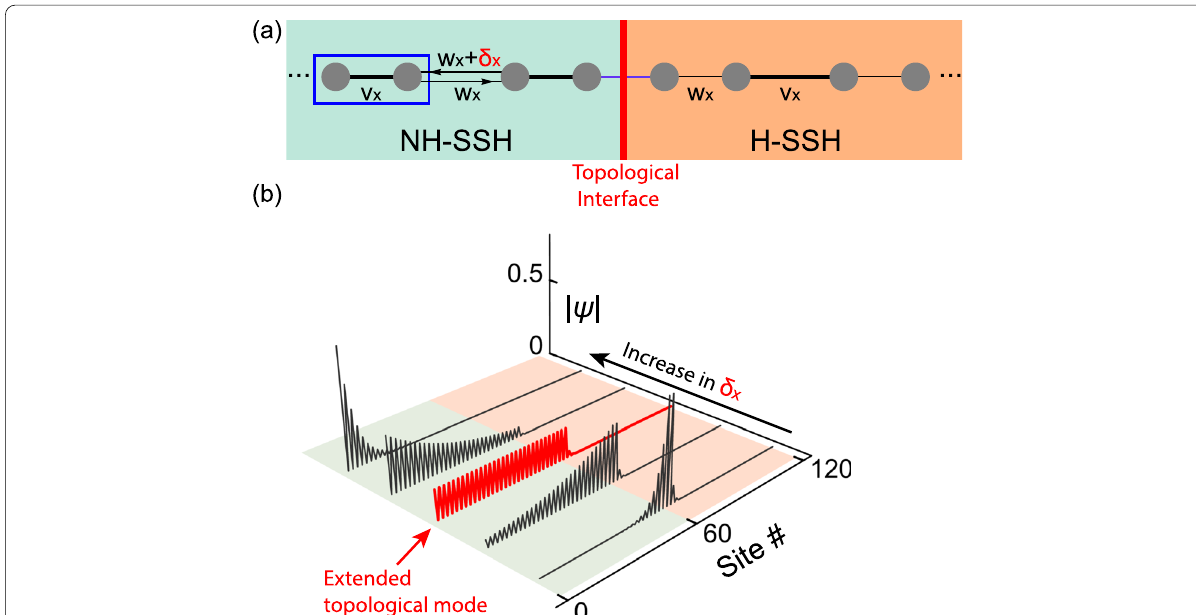
Fig. 1 a A one-dimensional topological interface (red line). The left part (green) is topologically trivial but is non-Hermitian, where the non-reciprocal hopping term δ x is responsible for the non-Hermiticity. The right part (orange) is topological and Hermitian. Here, the hopping terms are | v x | > | w x |. b The magnitude of the wavefunction of the topological mode is denoted as | ψ |. The localization property of the topological mode is drastically affected by δ x . It can be fully extended in the non-Hermitian half chain